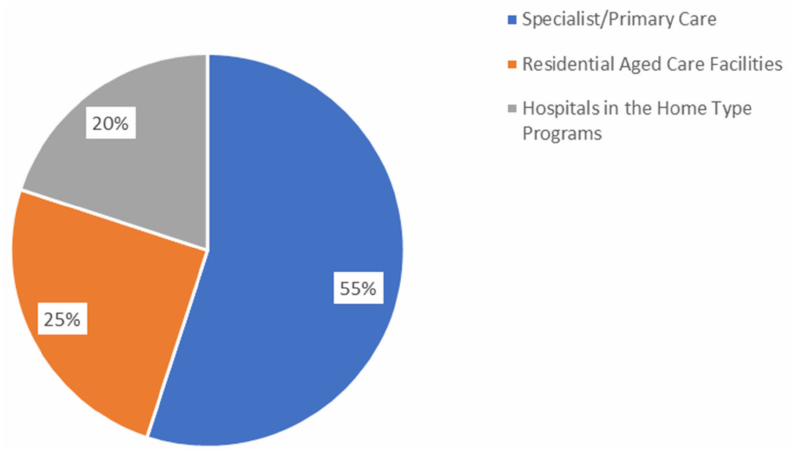
Figure 4. Settings in which virtual care initiatives were reported (Note: specialist and primary care were categorised together to reflect community